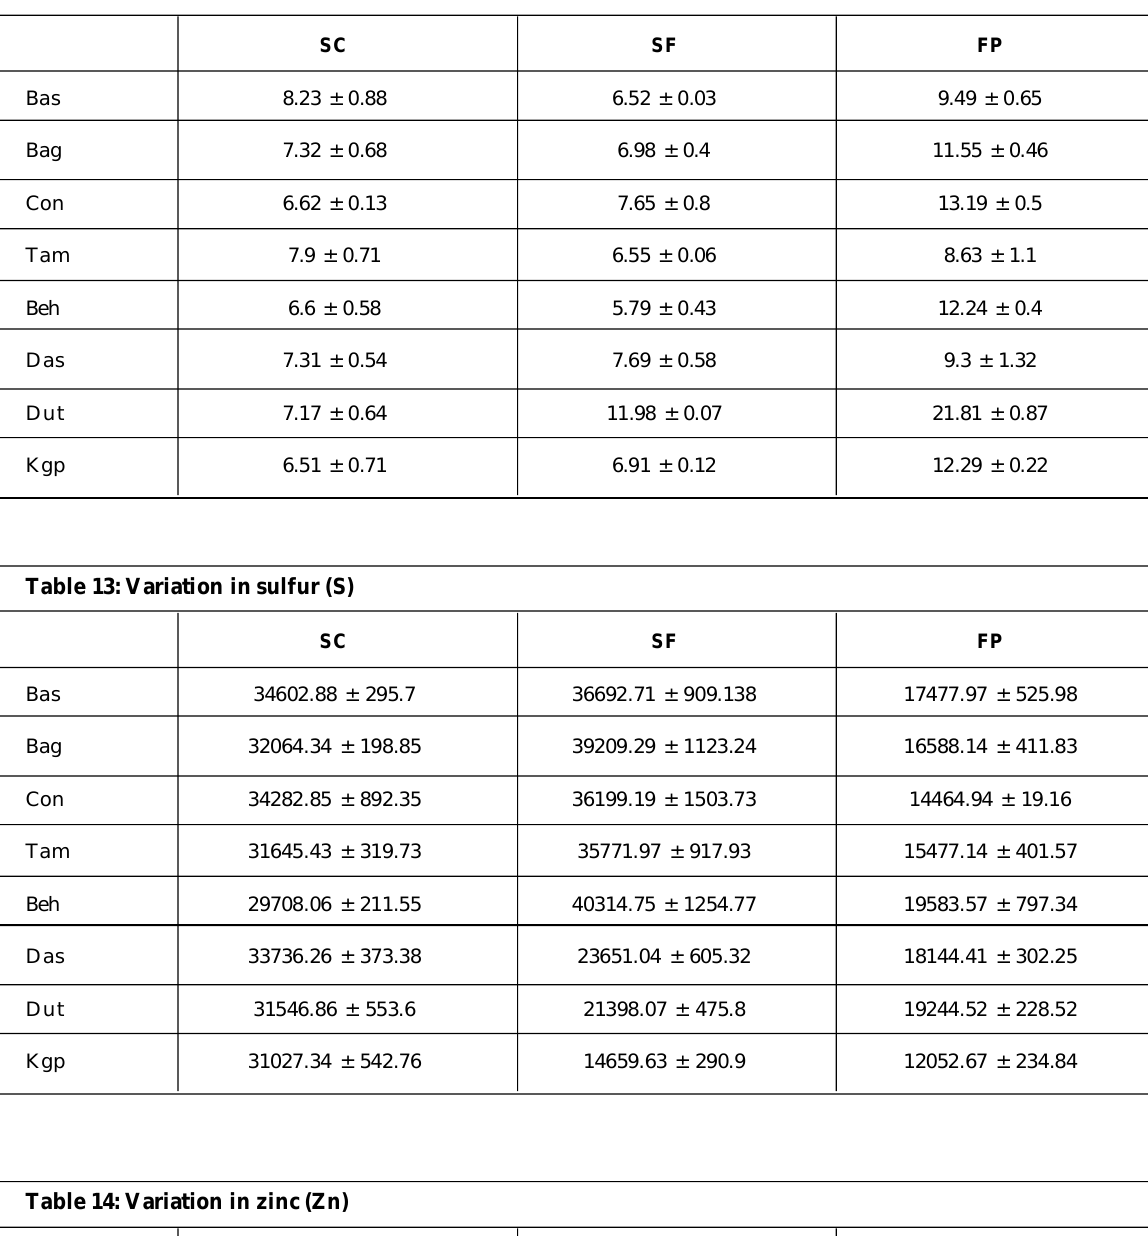
Table 12: Variation in strontium (Sr)